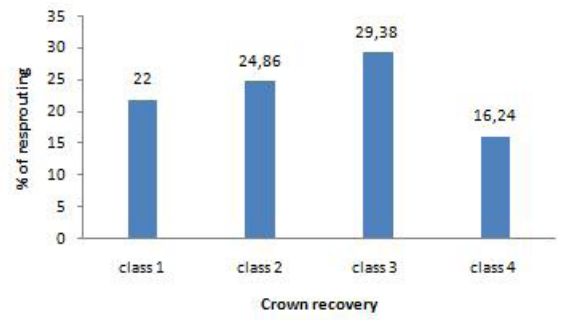
Figure 8. Histogram displaying the relation between the two types of cork oak post fire responses (the resprouting ability variability in function of crow